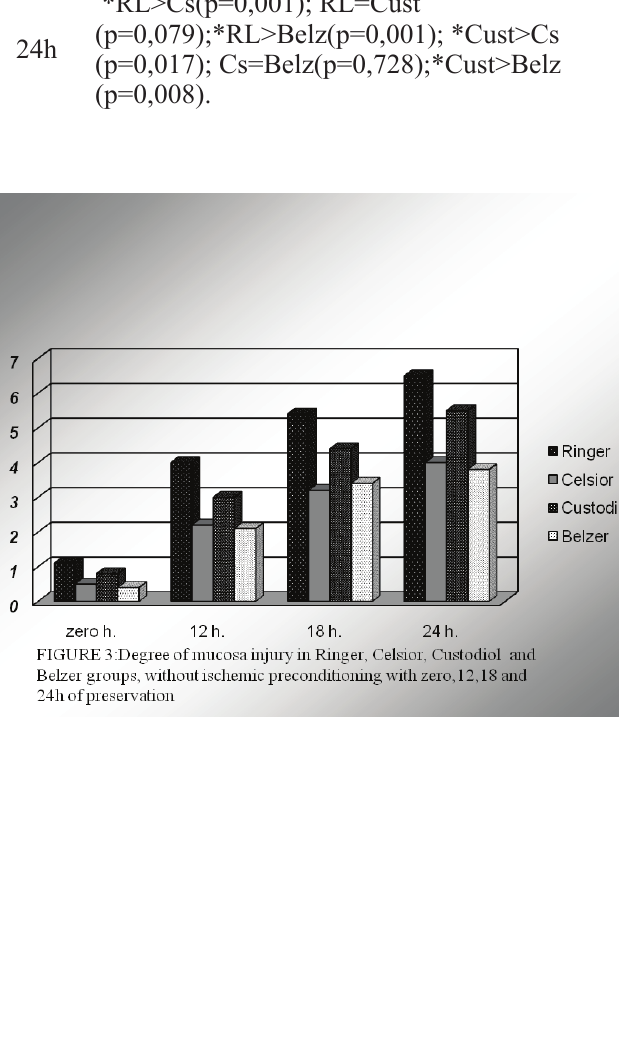
Ringer Celsior Custodiol 24 h.